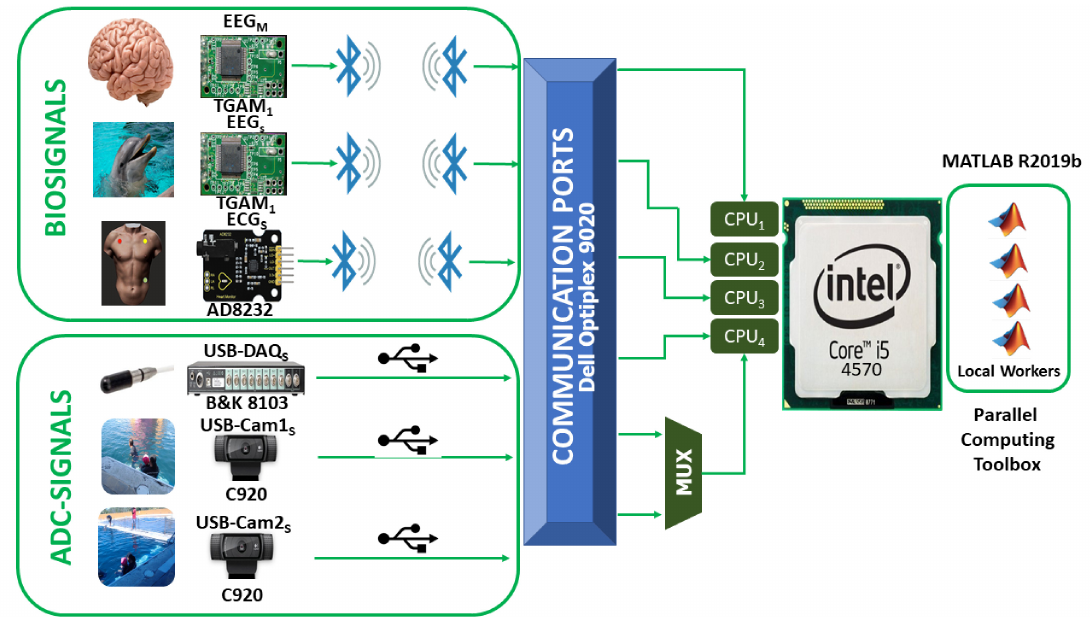
Figure 9. Architecture of System for monitoring biomedical signals using parallel